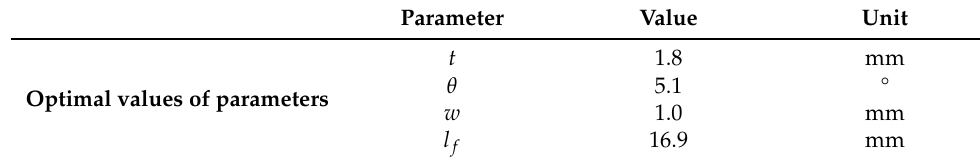
Figure 7. The sensitivity of optimized structural parameters. Table 4. Final optimized structural parameters.